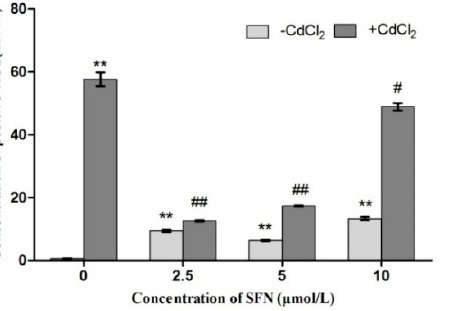
Figure 8. Level of ROS in TM3 cells.